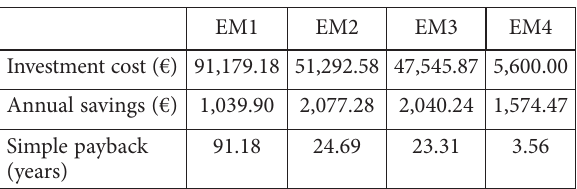
Table 7. Investment costs, annual savings and Simple Payback of the efficiency measures EM1 to EM4